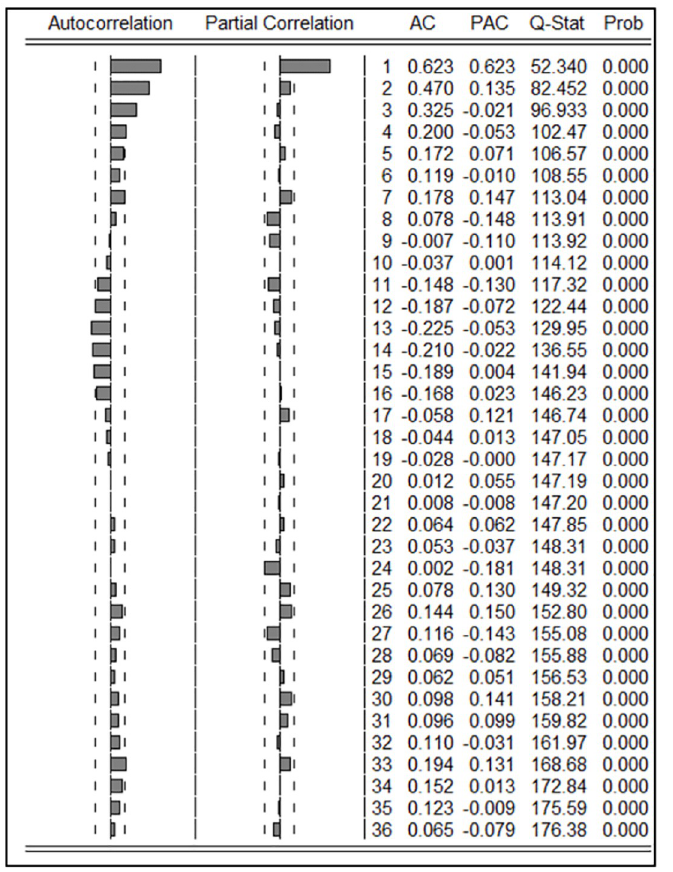
Fig 4. Autocorrelation function and partial autocorrelation function of seasonality adjusted; natural log- transformed monthly leptospirosis cases from January 2008 to December 2018, up to 36 lags. AC-Autocorrelation, PAC-Partial autocorrelation, Q-Stat-Ljung-Box test statistic, Prob-Probability (P-value).